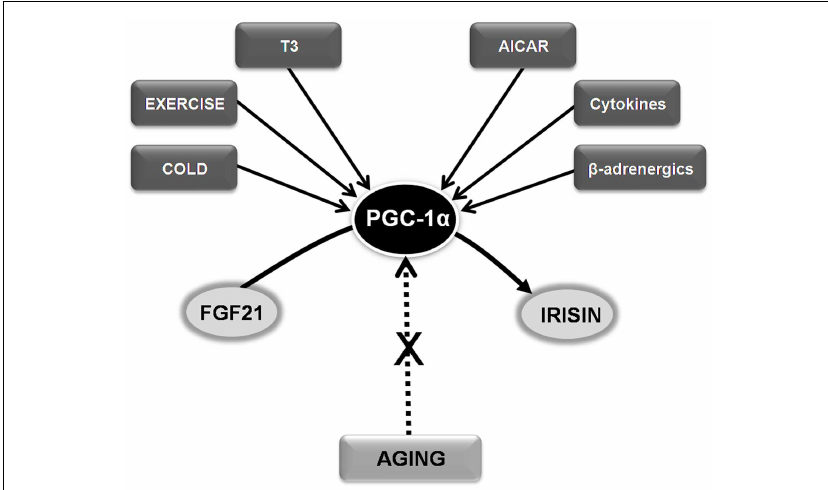
FIGURE 1 | Hypothesizing the role of FGF21-PGC-1 α -Irisin axis in age-related conditions and sarcopenia . See text for abbreviations.